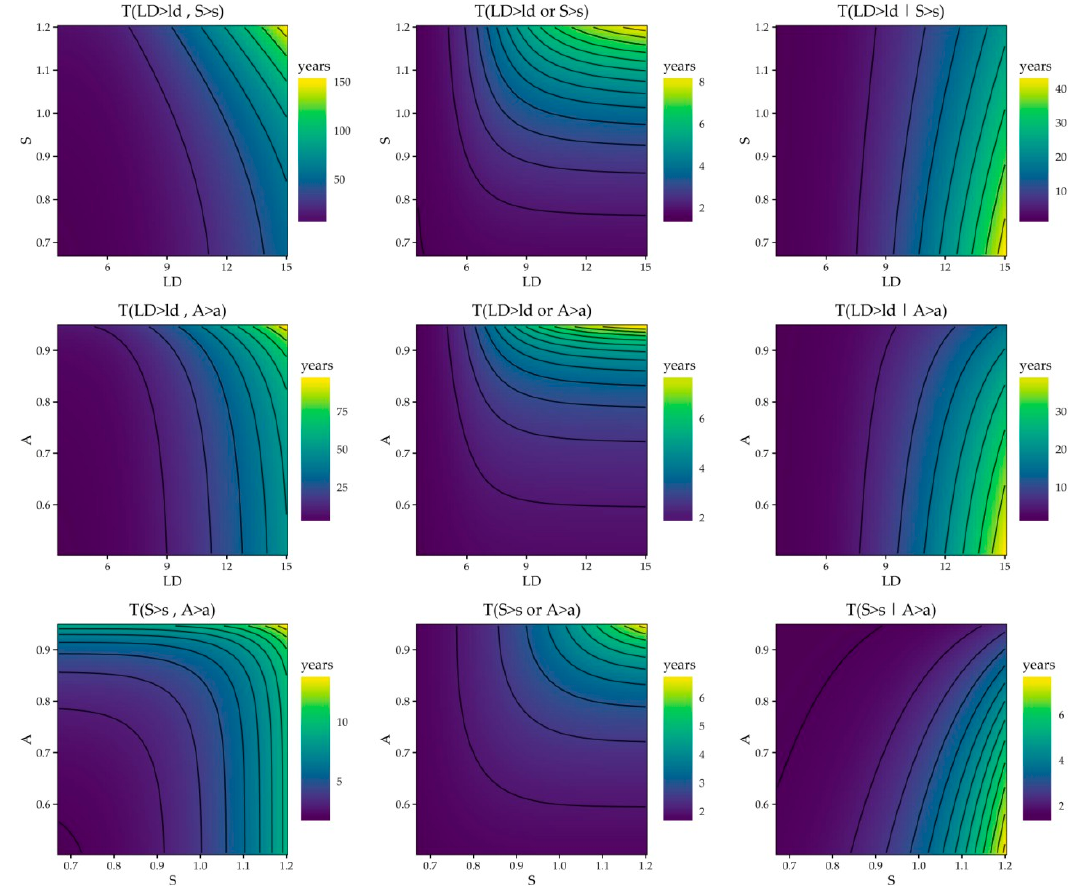
Figure 4. Bivariate T of drought characteristics obtained using synthetic datasets, where LD is given in months and S and A are shown as S and A ,